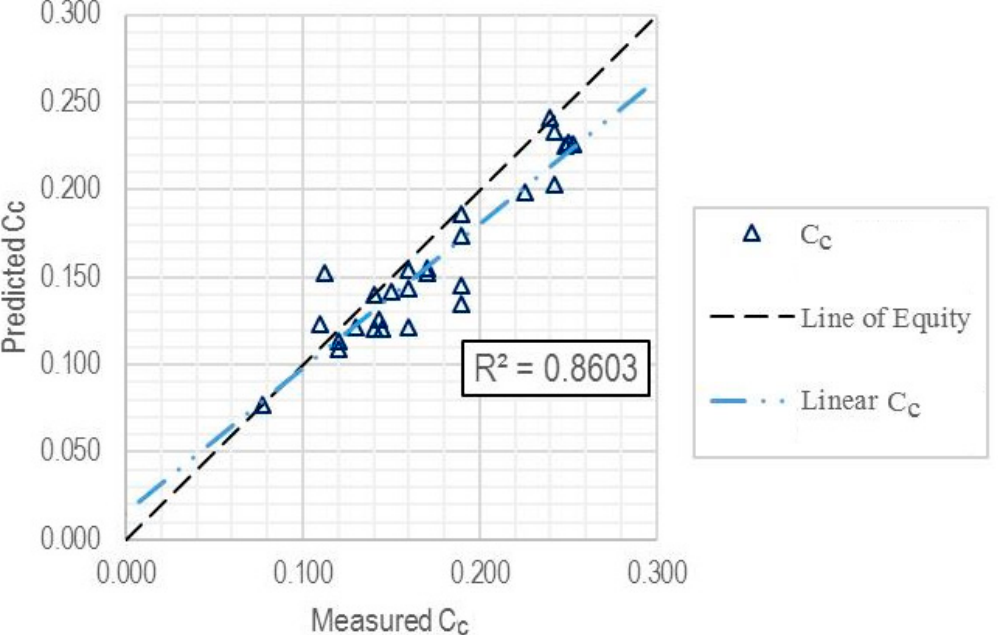
Figure 7. Predicted versus measured Cc for the validation subset.